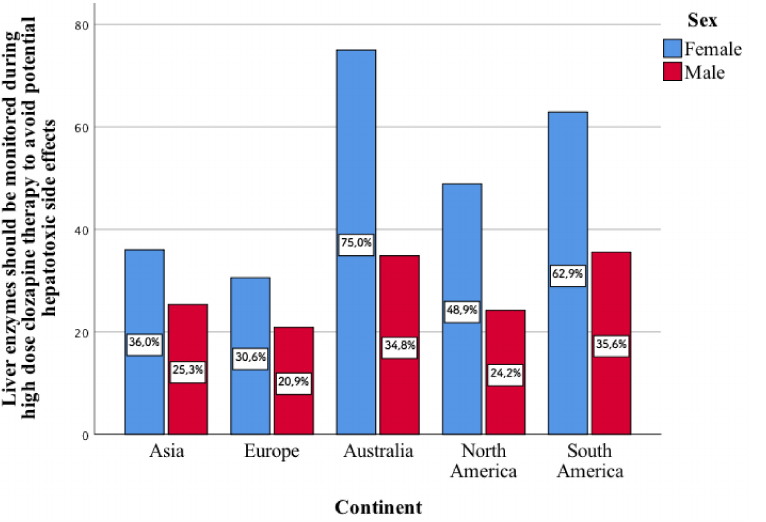
Figure 1. Opinion of the women and men surveyed on whether, in their opinion, the level of liver enzymes should be monitored during high-dose clozapine therapy in order to avoid potential side-effects related to